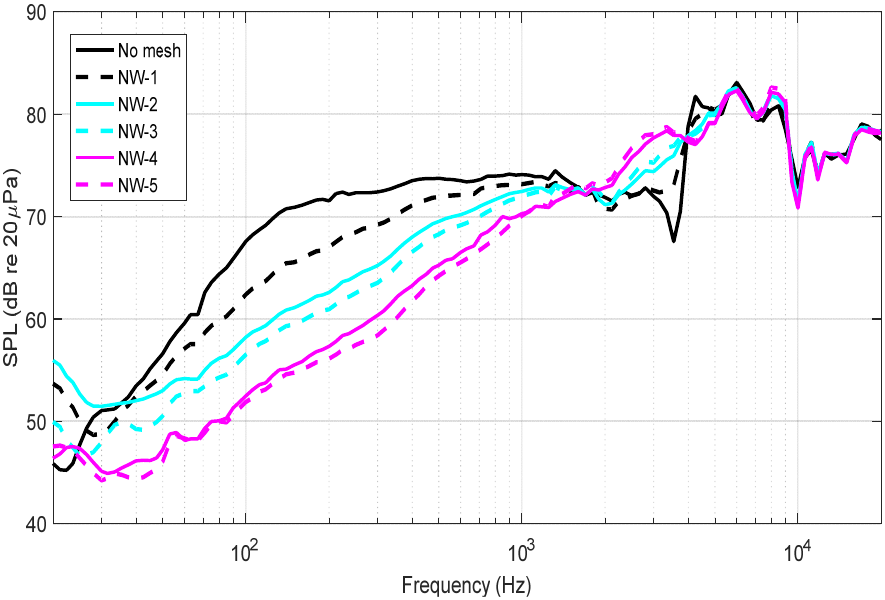
Figure 6. Measured frequency responses of microspeaker without and with non-woven ventilation cloths (NW-1 to NW-5).